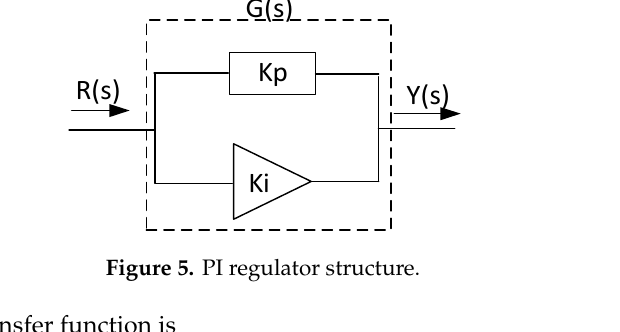
Figure 4. Control strategy of the ILC.